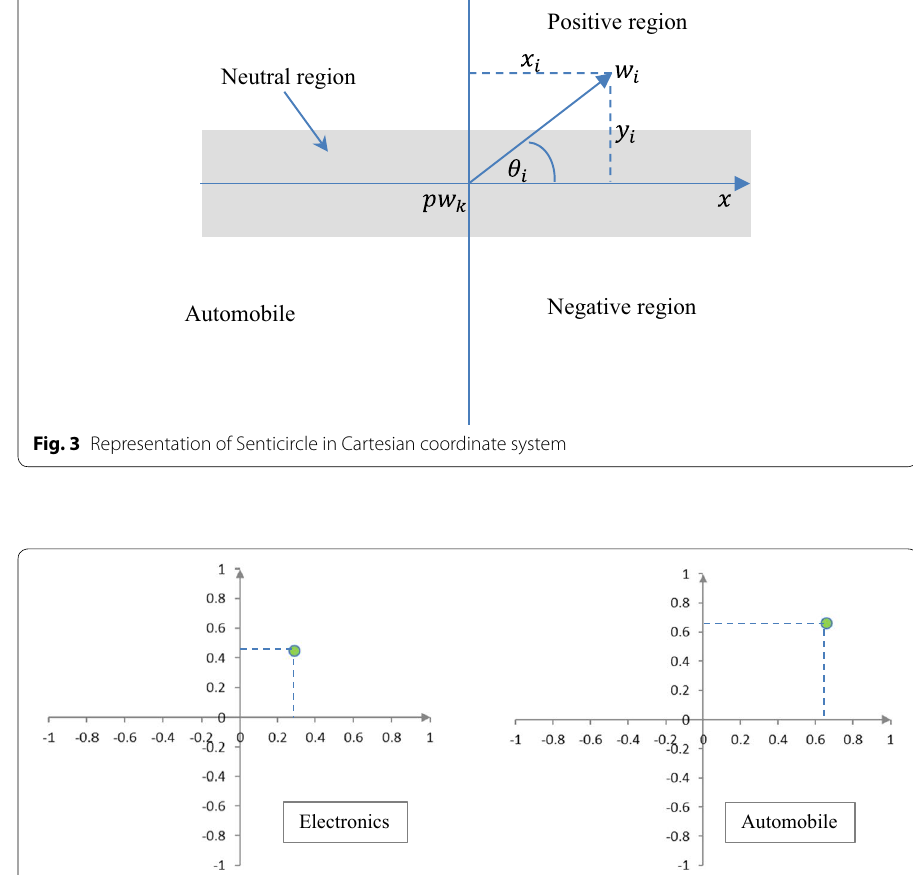
Fig. 4 Example of how Senticircle adjust Sentiment value of the word “long” of two different